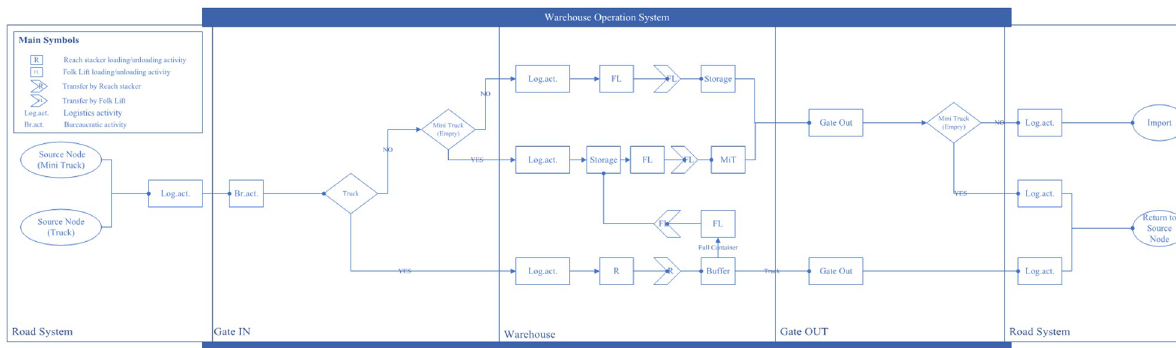
Fig 9. Operational flow of the warehouse operation system.